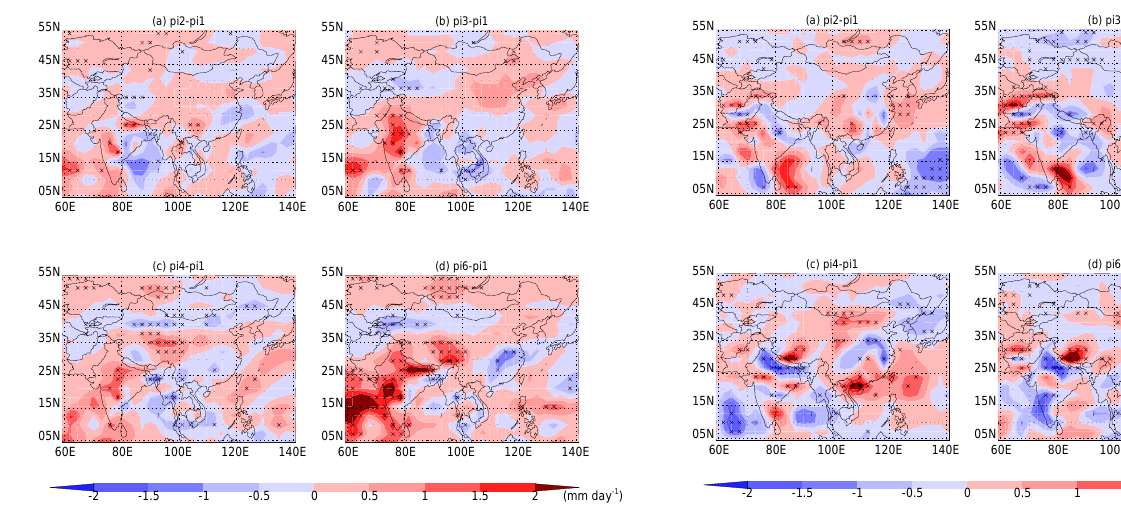
Fig. A1 Spatial distribution of changes for precipitation (shaded, Unit: mmday − 1 ) averaged for May for pi2-pi1 ( a , induced by CO 2 increase), pi3-pi1 ( b , induced by BC+OM in atmosphere), pi4-pi1 ( c , induced by BC in snow), and pi6-pi1 ( d , induced by CO 2 in- crease + BC+OM in atmosphere + BC-in-snow), respectively. The regions passing the 90% significance level are highlighted by cross.